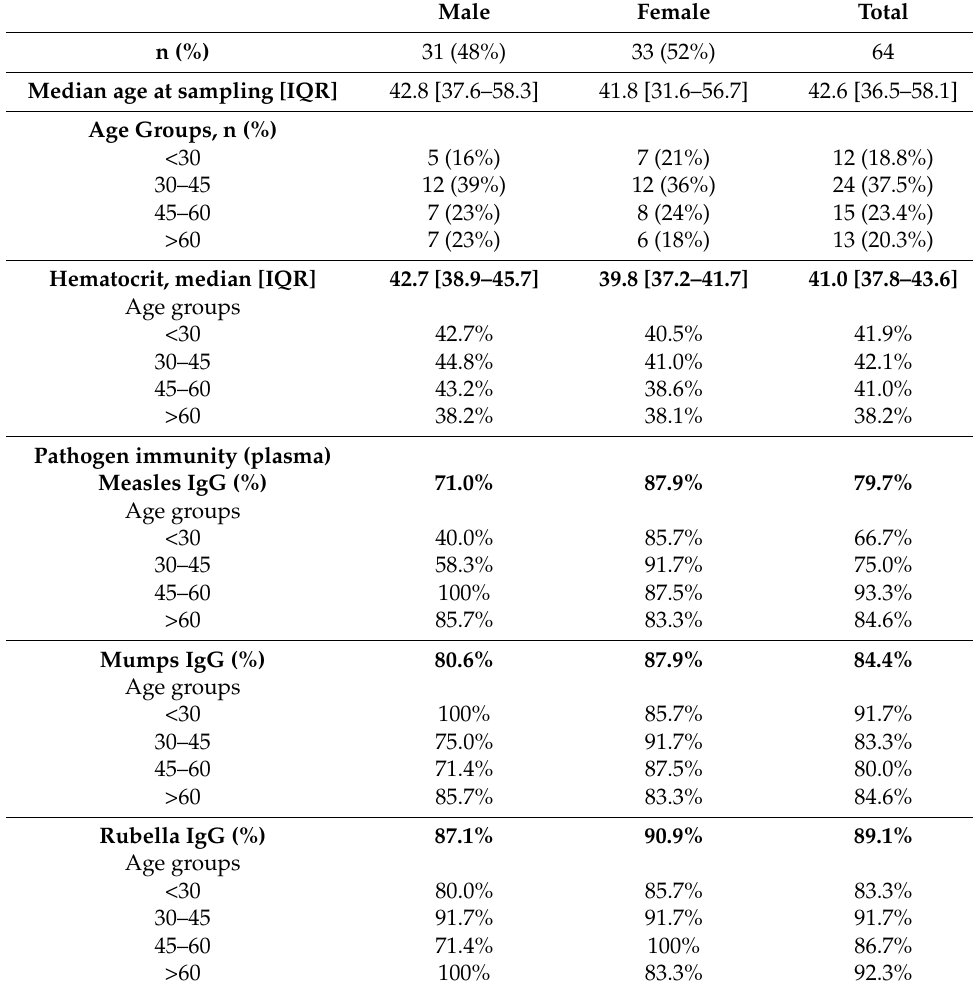
Table 1. Characteristics of the study population according to age